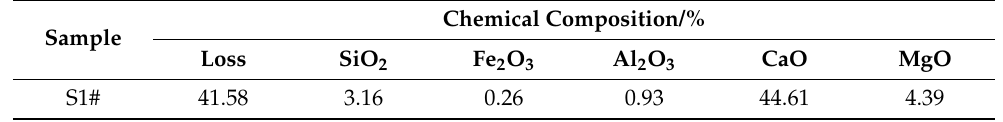
Table 2. Chemical composition of dolomitic limestone S1#